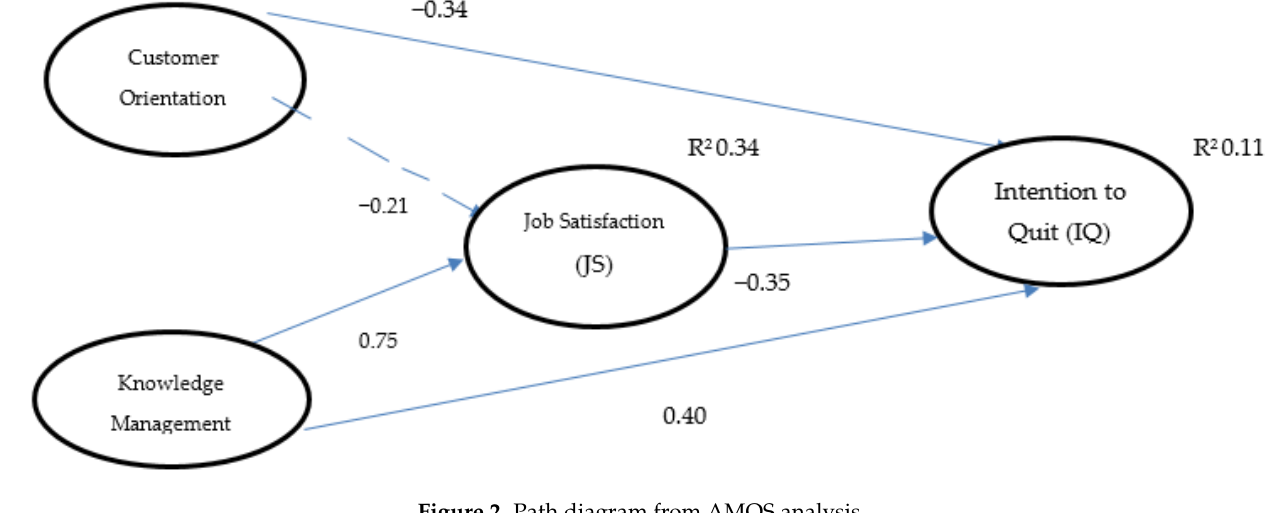
Figure 2. Path diagram from AMOS analysis. Table 5. Regression results.